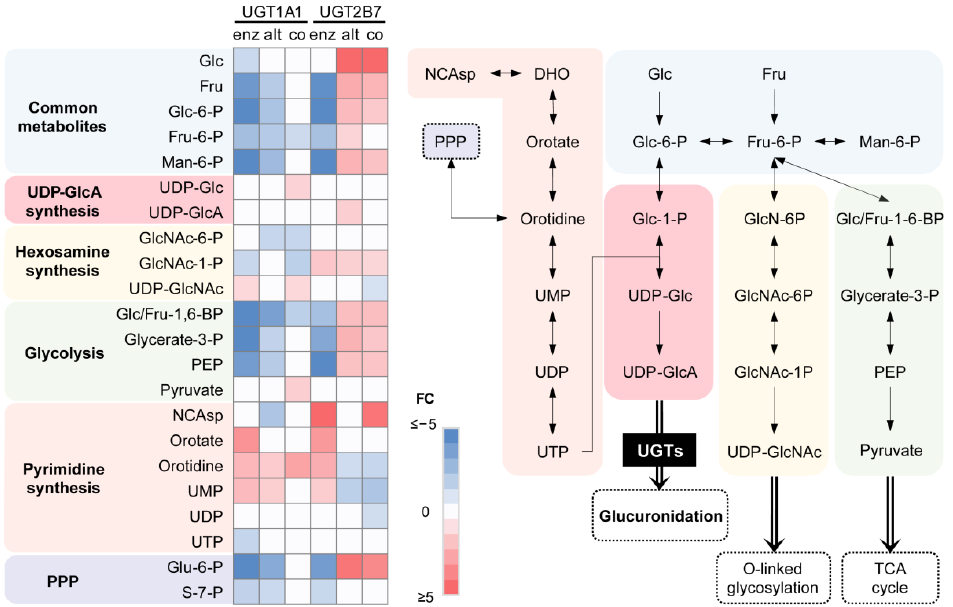
Figure 3. Metabolic precursors of UDP-GlcA synthesis are modified by UGT expression. Several metabolites of the pyrimidine, glycolytic and pentose phosphate pathways are preferentially altered in UGT enzyme-expressing cells. Fold changes (FC) relative to control cells are provided in the heatmap. Non-significant metabolites are displayed in white. Note that glucose and pyruvate were supplemented by the medium. NCAsp, N-carbamoyl aspartate; DHO, dihydroorotate; UMP, uridine monophosphate; UDP, uridine-diphosphate; UTP, uridine triphosphate; Glc, glucose; Glc-6-P, glucose- 6-phosphate; Glc-1-P, glucose-1-phosphate; UDP-Glc, UDP-glucose; UDP-GlcA, UDP-glucuronic acid; Fru, fructose; Fru-6-P, fructose-6-phosphate; GlcN-6P, glucosamine-6-phosphate; GlcNAc-6-P, N-acetyl-glucosamine-6-phosphate; GlcNAc-1-P, N-acetyl-glucosamine-1-phosphate; UDP-GlcNAc, UDP-N-acetyl-glucosamine; Man-6-P, mannose-6-phosphate; Glc/Fru-1-6-BP, glucose/fructose-1,6- bisphosphate; PEP, phosphoenolpyruvate; PPP, pentose phosphate